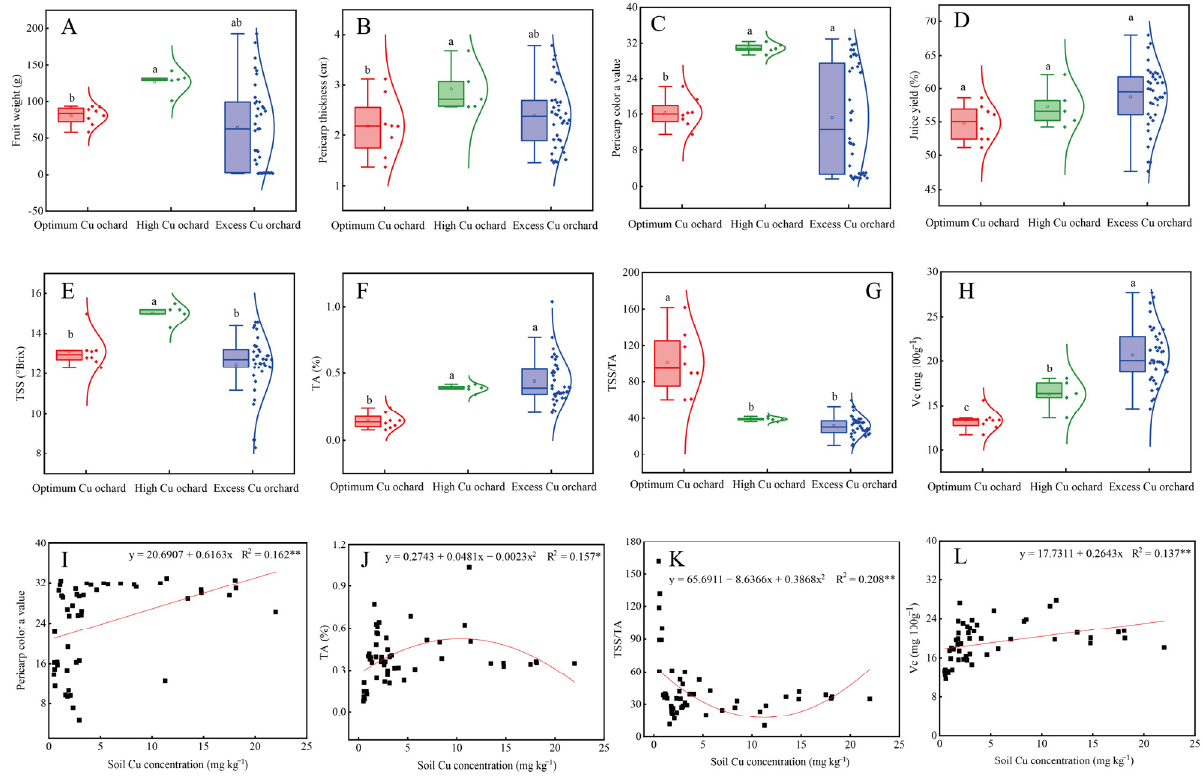
Figure 2. The characteristics of fruit qualities under different soil Cu levels ( A – H ) and the regression analysis of pericarp color a value ( I ), TA ( J ), TSS/TA ( K ), and Vc ( L ) with the increasing soil available Cu concentrations. The different letters above the box plots indicate significant differences between different soil Cu levels at 5% level ( p < 0.05; n opimum Cu level = 8, n high Cu level = 5, n excess Cu level = 38). * and ** superscripts after R 2 values indicate statistical differences at p < 0.05 and p < 0.01, respectively.